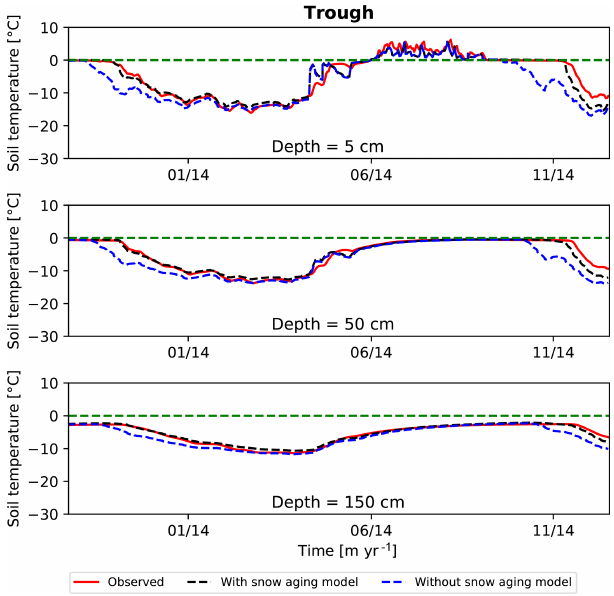
Figure 10. Simulated temperature versus time with and without the snow aging model compared to observed